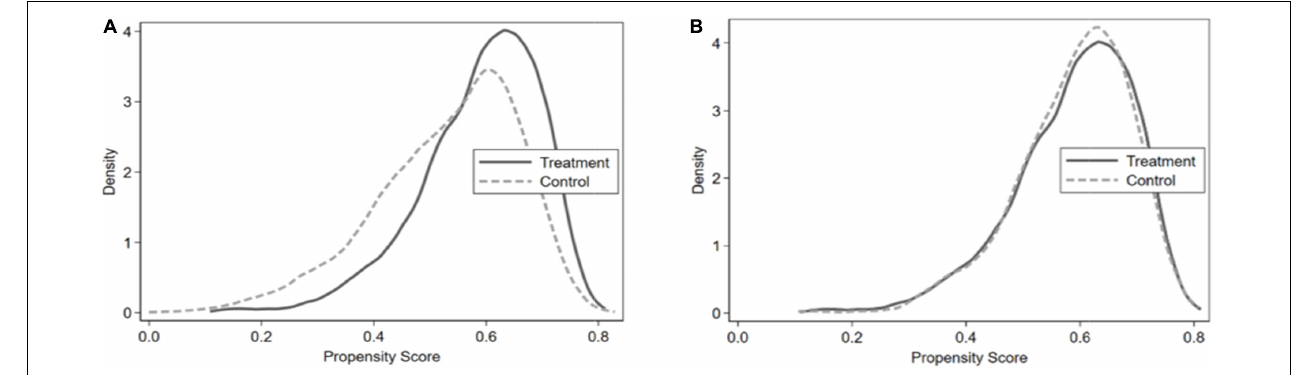
FIGURE 1 | Probability distribution density